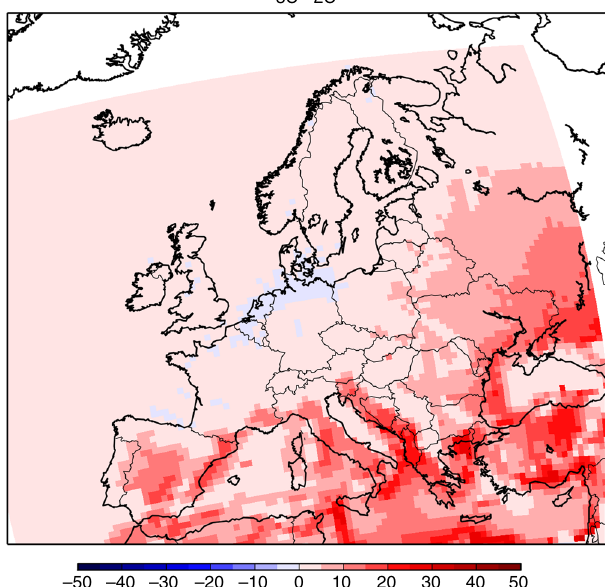
Fig. 7 Summer differences of 3C minus 2C for the mean boundary layer height. The mean is calculated from the 30-year period of the different scenarios. Units are meters. This fi gure has been generated using the Matplotlib library for the Python programming language